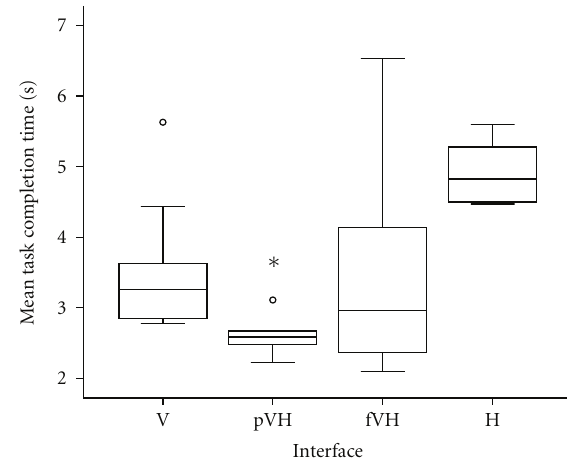
Figure 3: Boxplot showing the mean task completion time (s).